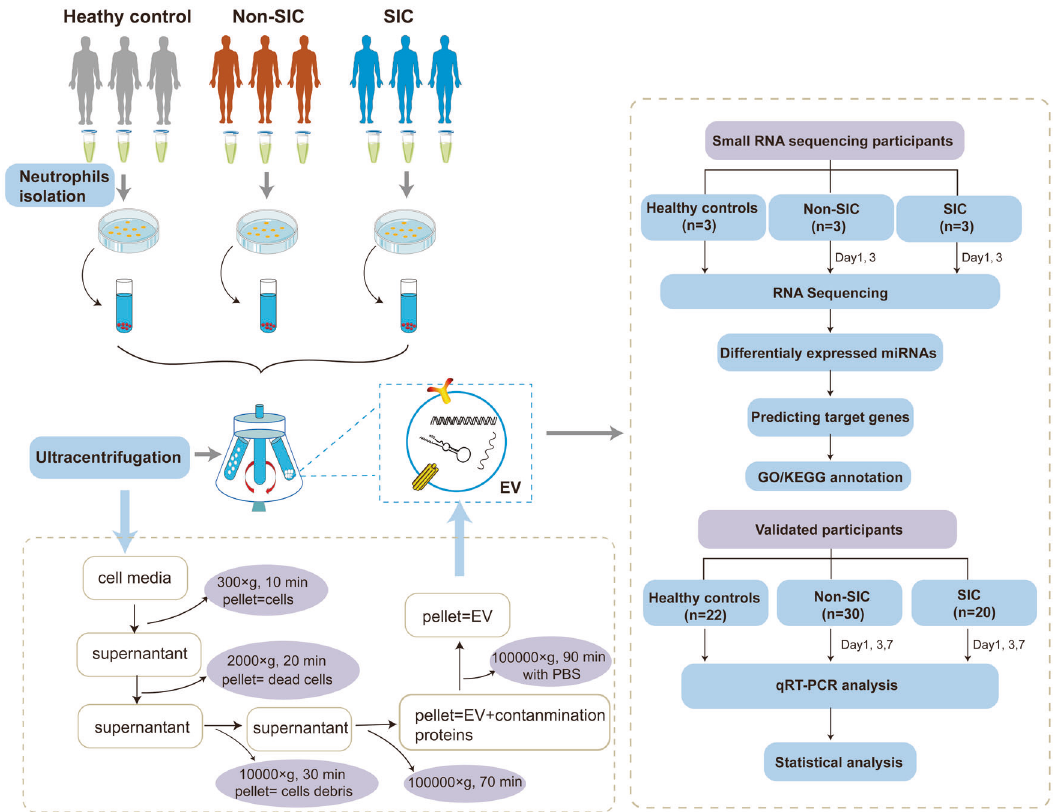
Fig. 6 The fl ow diagram for the experimental procedures. It included the sample collection, sEV extraction, and the small RNA sequencing analysis of sEV from neutrophils in septic